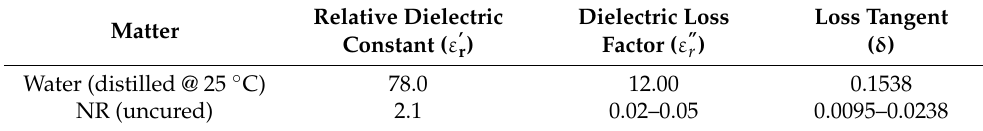
Table 2. The dielectric properties of water and NR